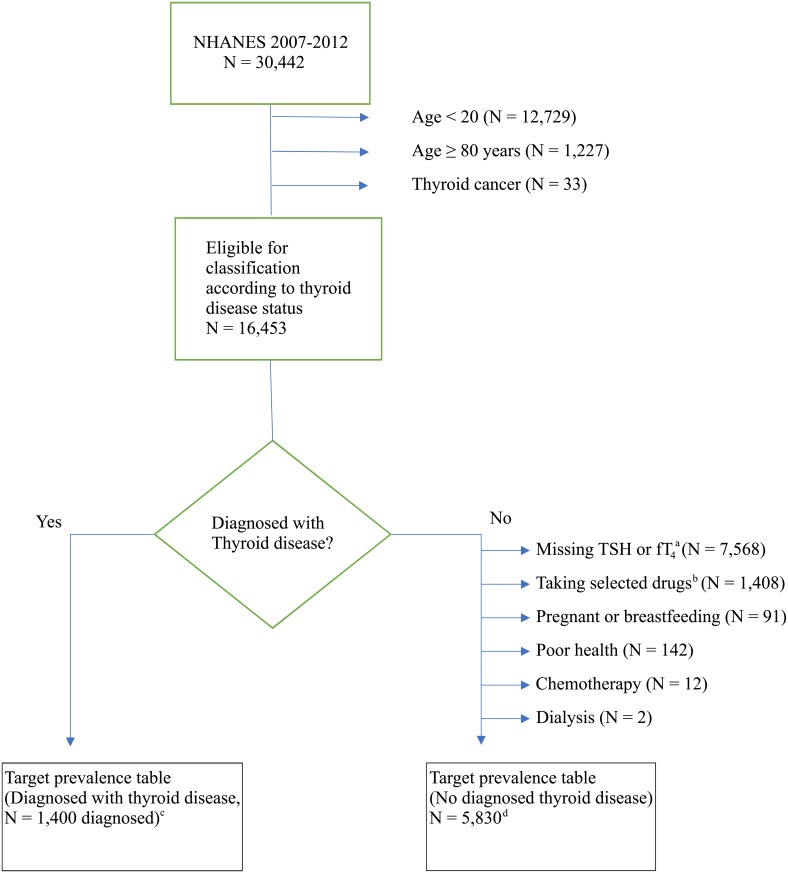
Flow chart showing population selection from the total NHANES participants to the target tables for the MCM.(a) For subjects in the 2007 to 2008 wave of NHANES, thyroid hormone levels were measured in all subjects over age 12 not meeting other exclusion criteria. For subjects from the 2009 to 2010 and 2011 to 2012 waves of NHANES, thyroid hormone levels were measured in a one third subsample of subjects over 12 not meeting other exclusion criteria. (b) Taking drugs that affect thyroid hormone concentrations. (c) Reported ever having thyroid disease, or on thyroid medication. Crude prevalence of ever diagnosed with thyroid disease was 8.5% (1,400/16,453). (d) These people were classified according to thyroid disease status on the basis of their serum concentrations of TSH and fT4.